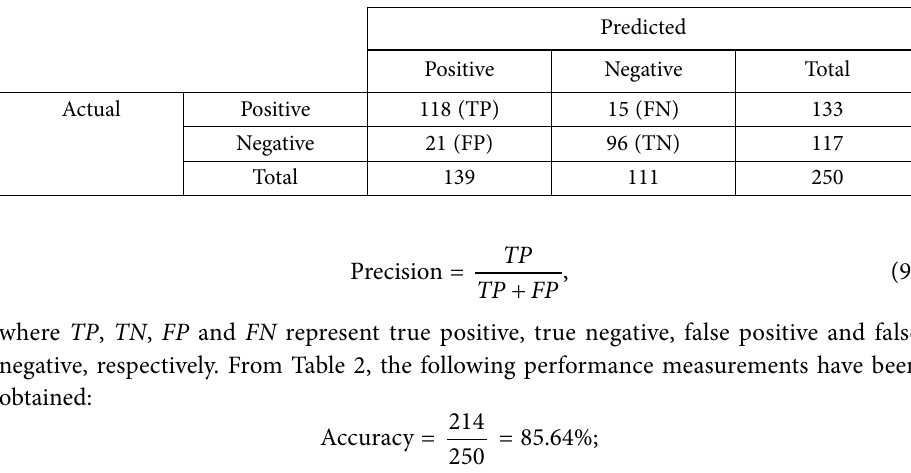
Table 2. Performance evaluation of invoice debts